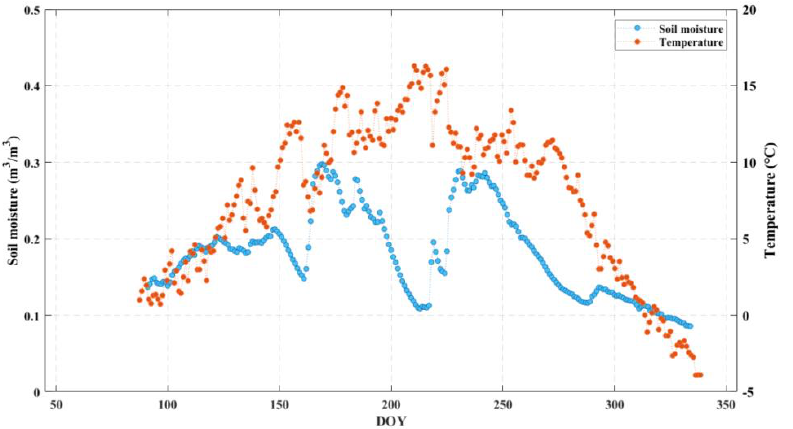
Figure 2. Temporal profile of averaged soil moisture and temperature measured over the 43 sta- tions in 2015.